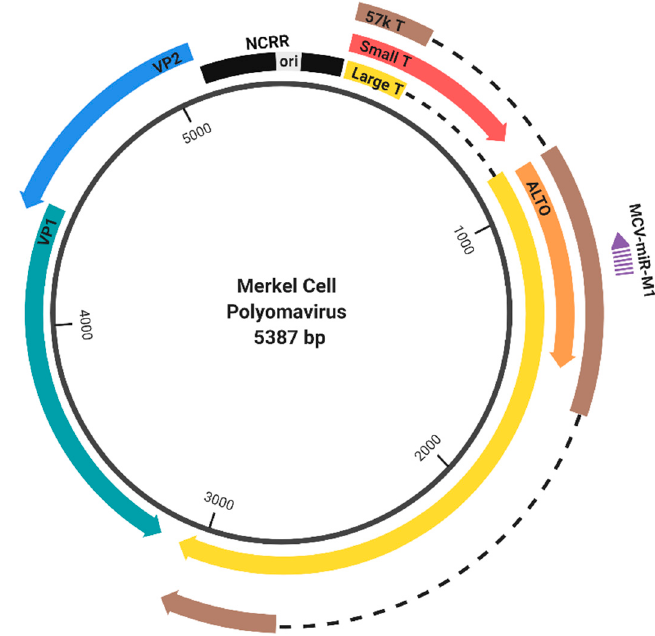
Figure 1. Genome organization of Merkel cell polyomavirus (MCPyV). The MCPyV genome is divided into the early (right) and late (left) region by the noncoding regulatory region (NCRR) [4]. The early region encodes large tumor antigen (LT), small tumor antigen (sT), and the 57 kT antigen by di ff erential splicing, as well as the protein encoded by an Alternate frame of the LT open reading frame (ALTO) [7,8]. The late region encodes the capsid proteins, VP1 and VP2. Gene expression is regulated by NCRR, which contains the origin of replication (ori) and the promoters that drive early and late gene expression. MCPyV also encodes a microRNA (MCV-miR-M1), which targets early transcripts [9].